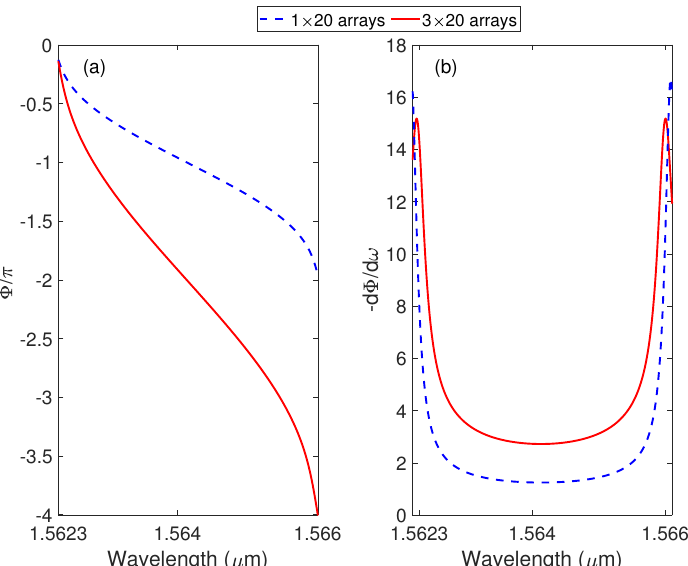
Figure 4. ( a ) Phase response and ( b ) the relative group delays for the drop port of the 1 × 20 arrays (blue dashed line) and the 3 × 20 arrays (red solid